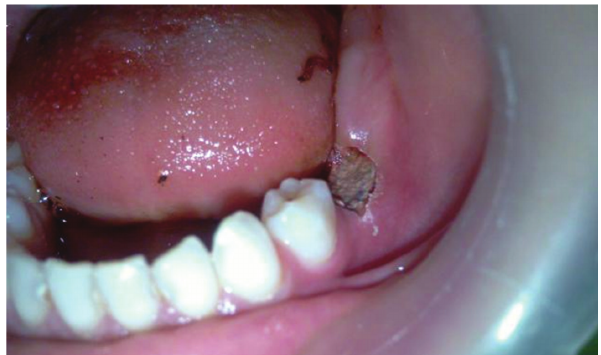
Figure 1: Intraoral view of the left second submerged primary man- dibular molar.